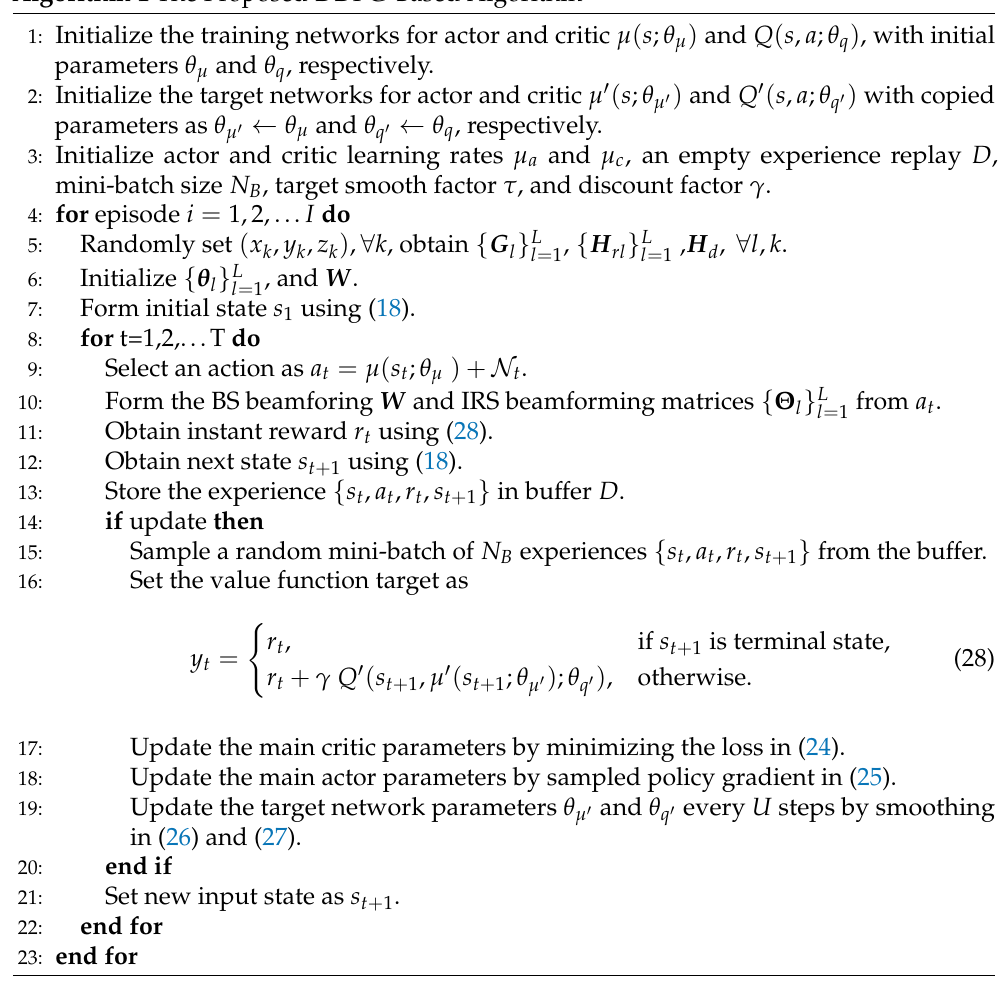
Algorithm 1 The Proposed DDPG-Based